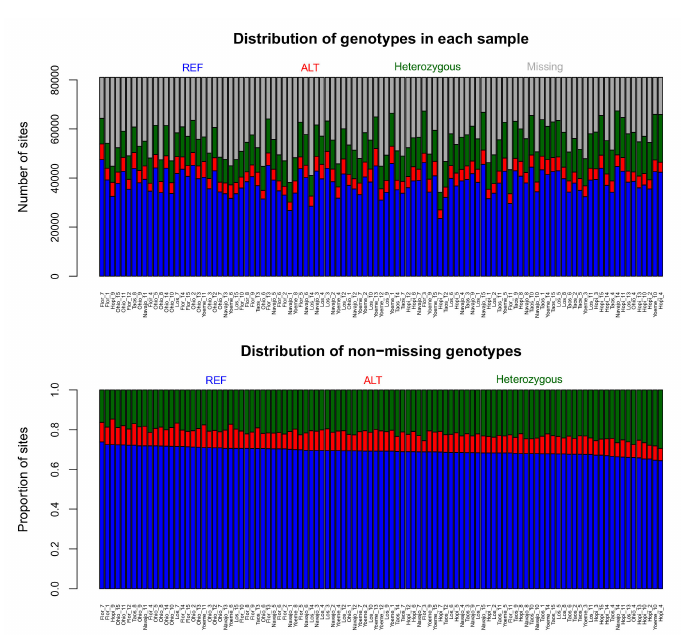
Figure 2. Sample-based, low missing data (LMD50) SNPs genotype summary. LMD50 refers to low missing data, each of which was genotyped in at least 50% of the samples. The top panel shows the summary of SNP genotypes includes the number of SNPs those are homozygous for the REF allele (reference allele), homozygous for the ALT allele (alternate allele), and heterozygous among missing data. The bottom panel shows the proportions of the SNPs per sample that are homozygous for the REF allele, homozygous for the ALT allele, or heterozygous among the non-missing data.